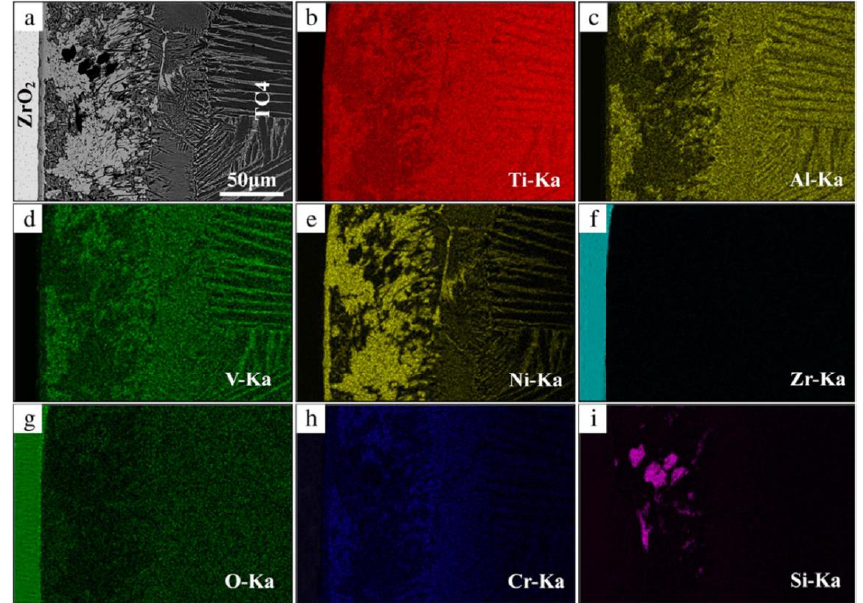
Figure 11. Interfacial morphology and elemental distribution of Ti6Al4V and ZrO 2 joint brazed at 1000 °C for 10 min. ( a ) SEM image of the joint and EDS elemental maps distribution images of ( b ) Ti, ( c ) Al, ( d ) V, ( e ) Ni, ( f ) Zr, ( g ) O, ( h ) Cr, ( i ) Si, reproduced from Reference [35] with permission of Elsevier, 2013. Table 2. Brazing conditions and shear strength values of titanium alloys and ZrO 2 joints. Titanium Alloy